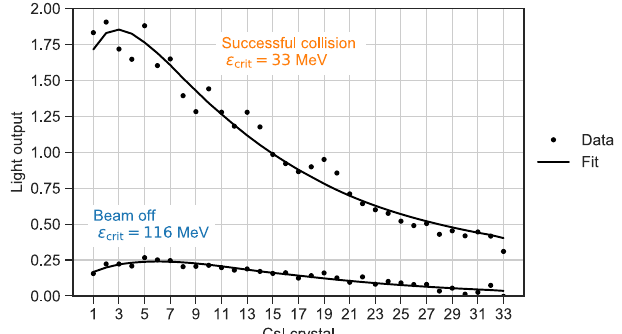
FIG. 6. CsI spectrometer measurements recorded for a suc- cessful collision and “ beam-off ” shots, and associated best-fit response functions from the Monte Carlo model of the detector. The maximum likelihood estimate of the fit parameter ε displayed next to each